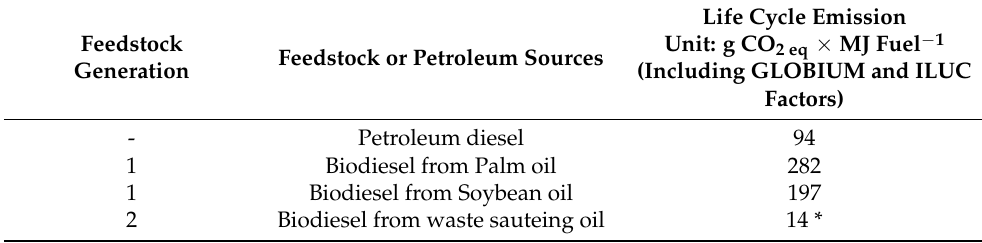
Table 3. Life cycle emission for some biodiesel